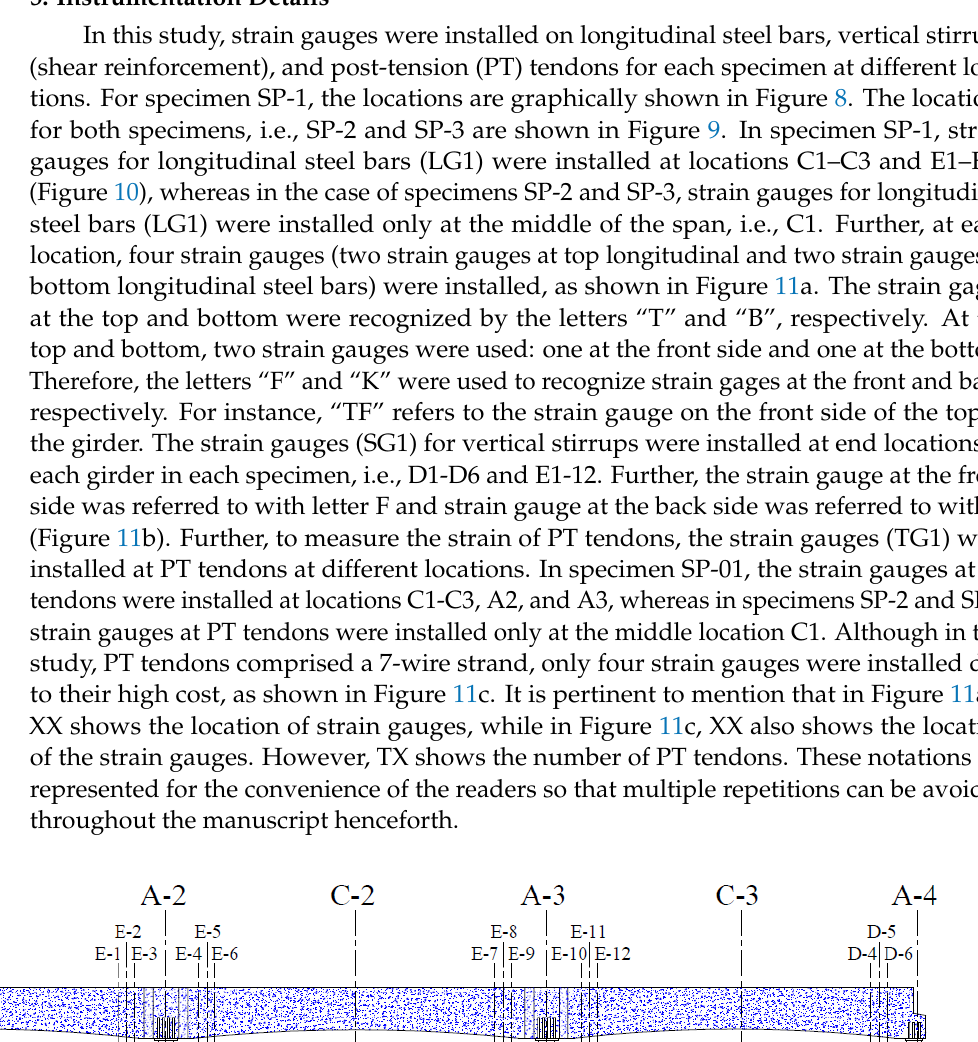
Figure 7. Details of bearing: ( a ) fixed bearing and ( b ) free bearing.